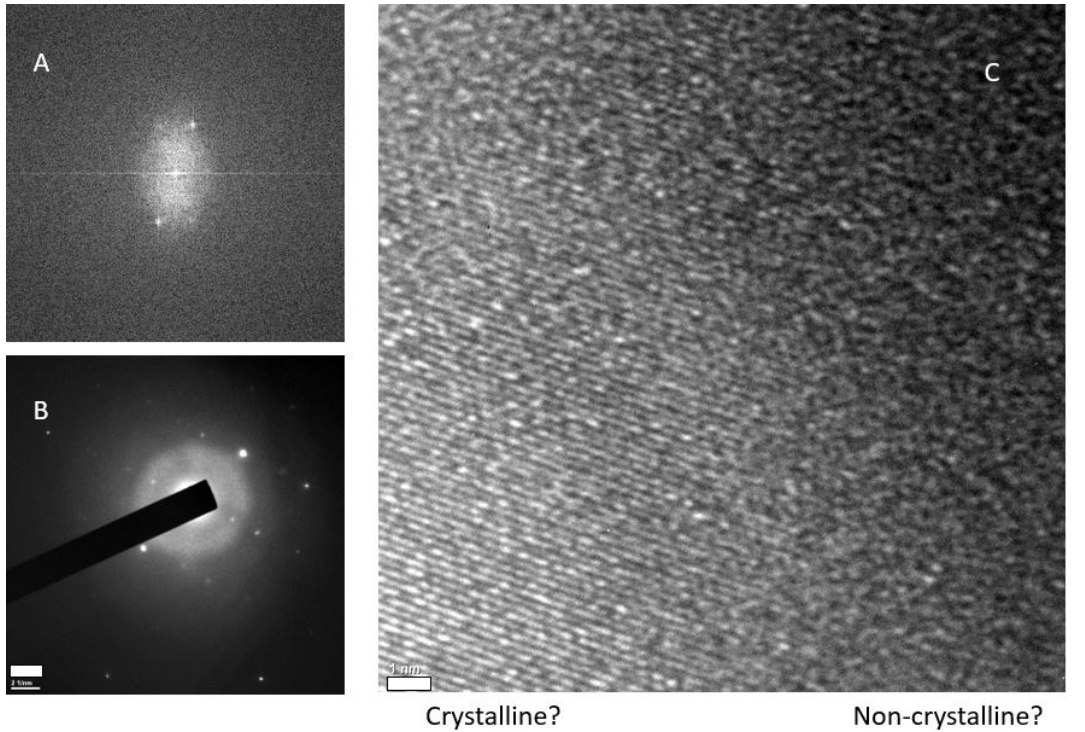
Figure 6. FFT ( A ) and selected area electron diffraction (SAED). ( B ) images of the crystalline area in the HRTEM image. The bar in the lower left corner equals 2 1/nm. ( C ). The scale bar in the lower-left corner of Figure 6 C equals 1 nm.